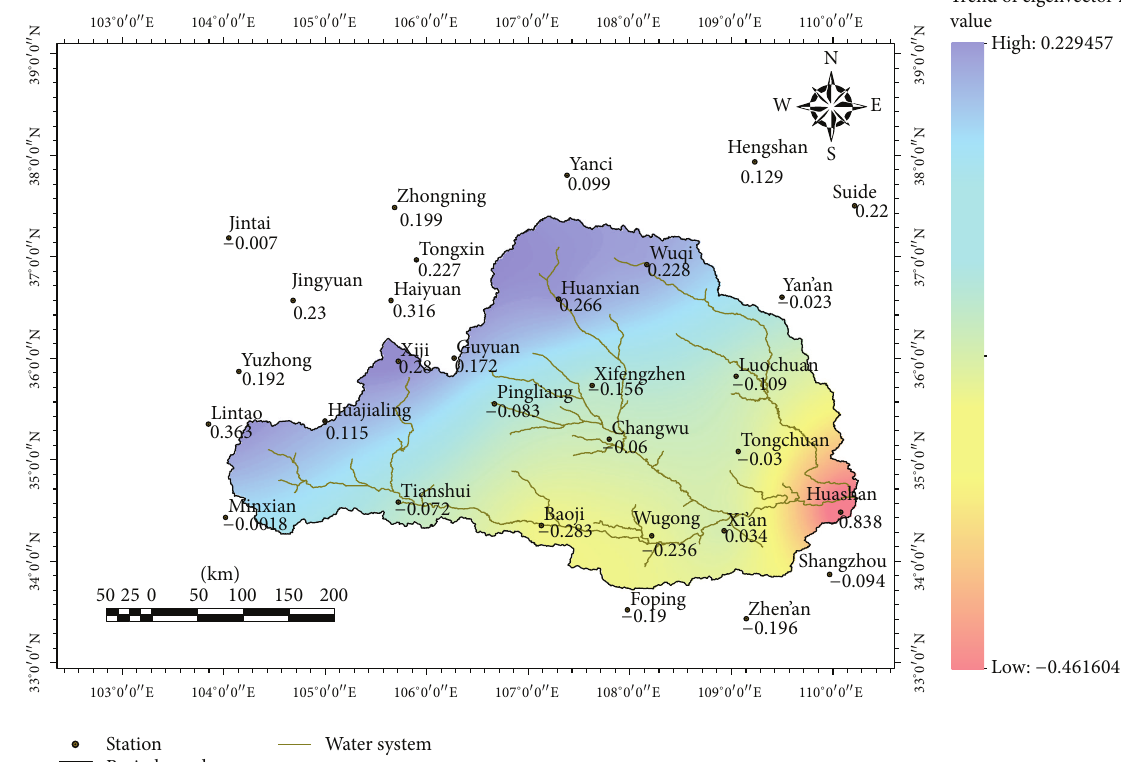
Figure 5: The eigenvector 2 trend field for annual precipitation in the Weihe